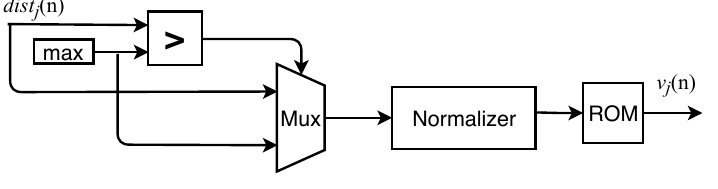
Figure 3. Kernel computation.